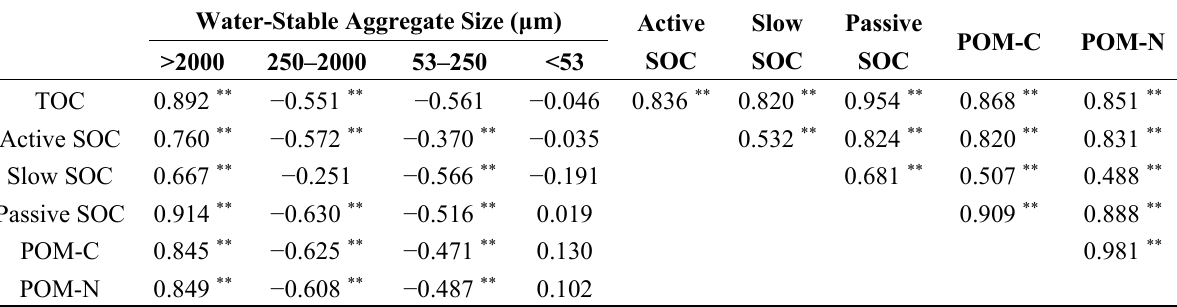
Table 6. Pearson’s coefficients of correlation ( R ) between the various soil organic carbon (C) fractions and the proportion of water-stable aggregates ( n = 5). Water-stable